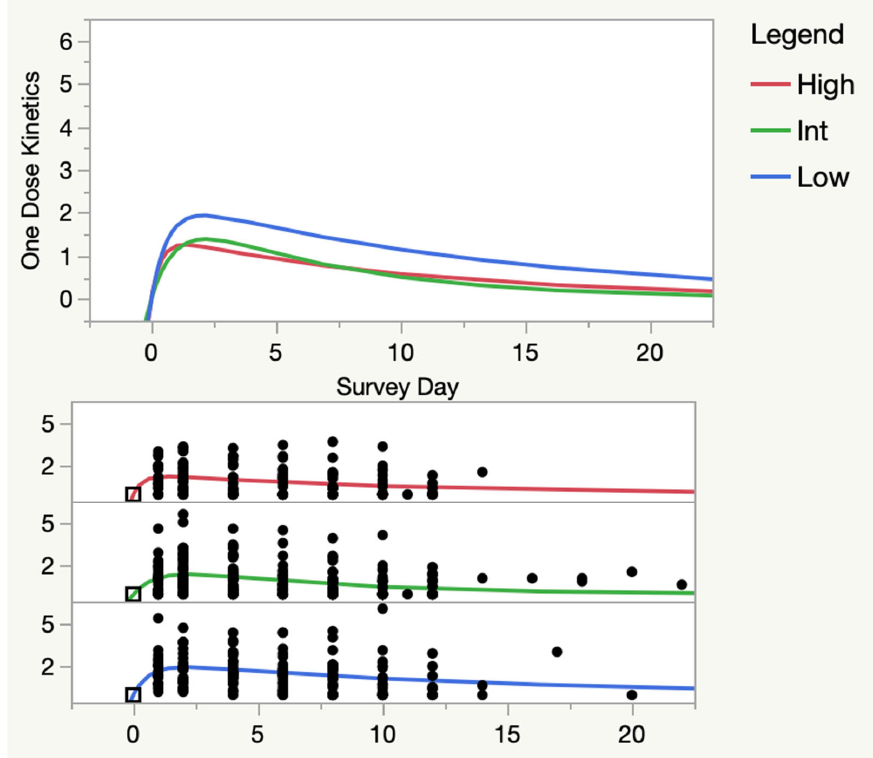
Figure 9. One ‐ Dose Pharmacokinetic Model by Pre ‐ CPET 1 Symptoms. One dose pharmacokinetic model by pre ‐ CPET1 symptoms—ME/CFS only. High, Intermediate (Int) and Low groups were as ‐ signed by their pre ‐ CPET1 mean SSS scores; High and low were the highest and lowest quartiles, Int was the middle two quartiles. Intermediate and high groups were not significantly different from the low group: High group vs. Int, F ratio = 0.05, N.S.; Low, F ratio = 0.01, N.S.; Int group vs. Low: F ratio = − 0.04, N.S. Black boxes represent that in this model all subject ʹ s Mean SSS scores were nor ‐ malized (set to 0 at time 0, or pre ‐ CPET1, for all subjects); Black dots are all other normalized Mean SSS scores for each subject, at subsequent days; Red, green and blue lines are the mathematical so ‐ lutions for each group in the model.